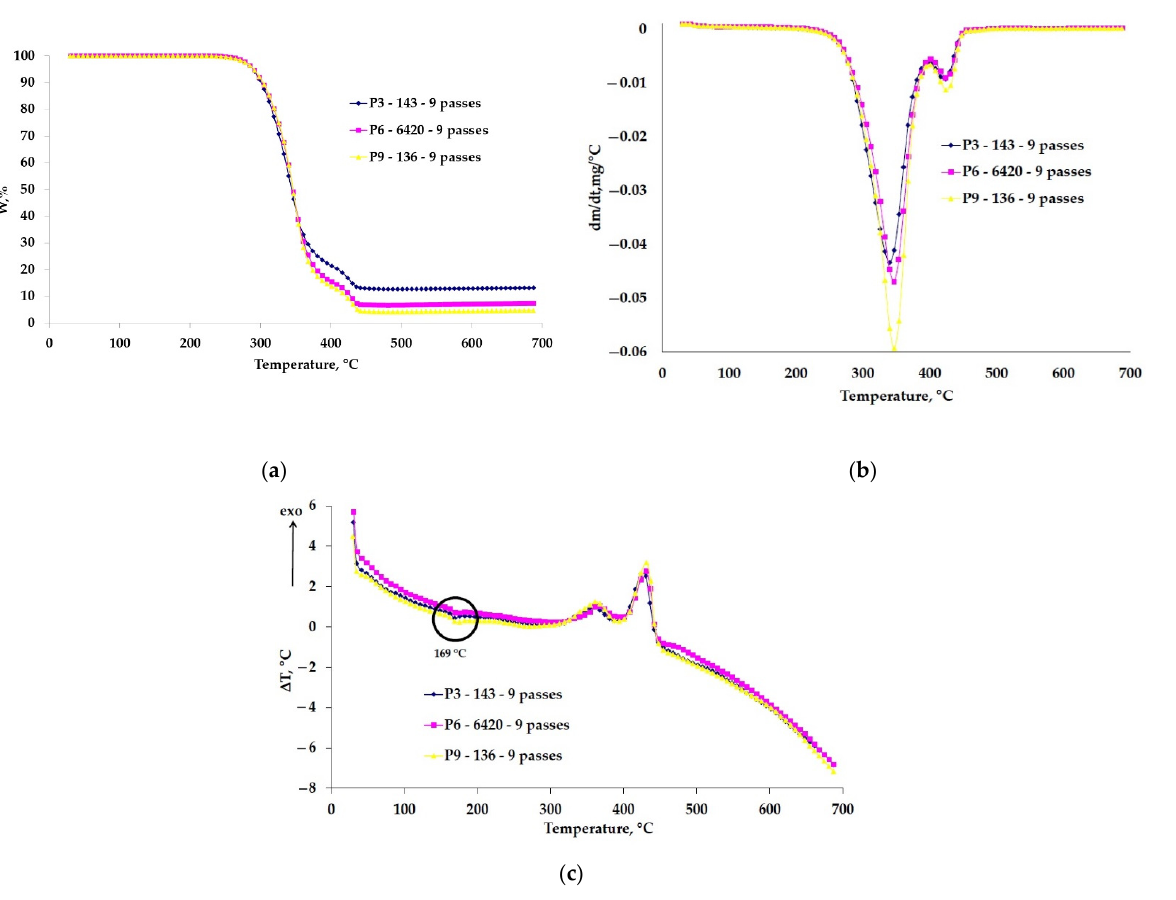
Figure 2. Thermogravimetric curves of the coated samples: ( a ) TG, ( b ) DTG and ( c ) DTA. The main thermogravimetric characteristics of the P3–143–9 passes, P6–6420–9 passes The curves obtained from the TG analysis were overlapped to highlight their and P9–136–9 passes samples are presented in Table 4. Table 4. Thermogravimetric characteristics of the samples covered with ceramic micropowders.